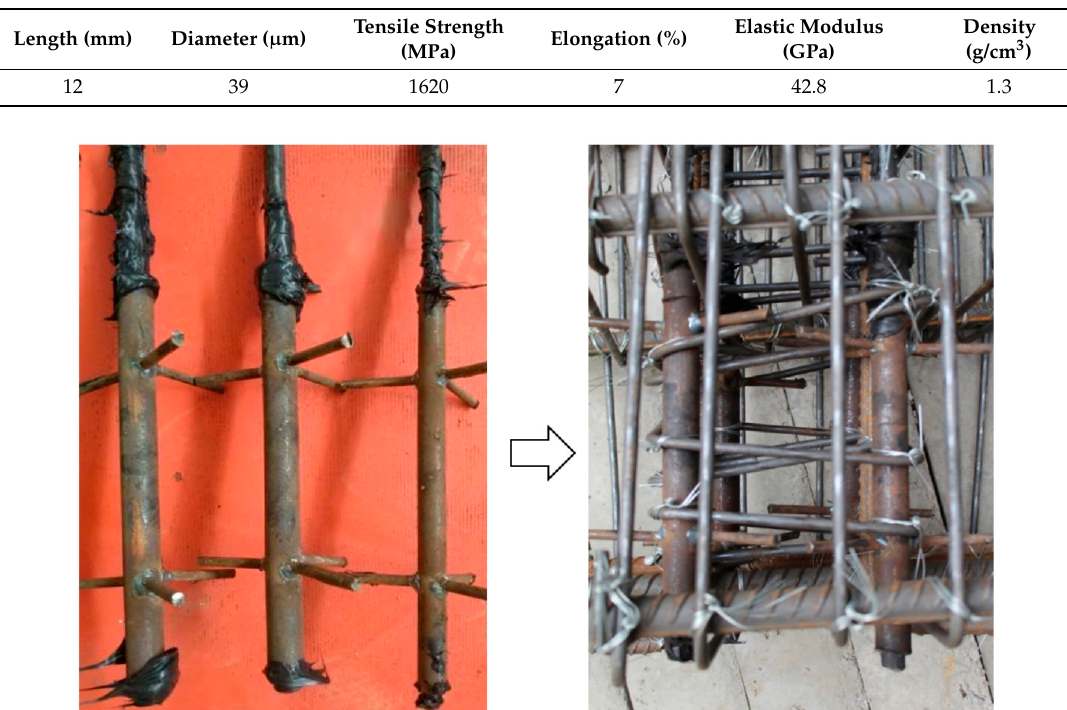
Figure 3. End anchoring of FRP bars.